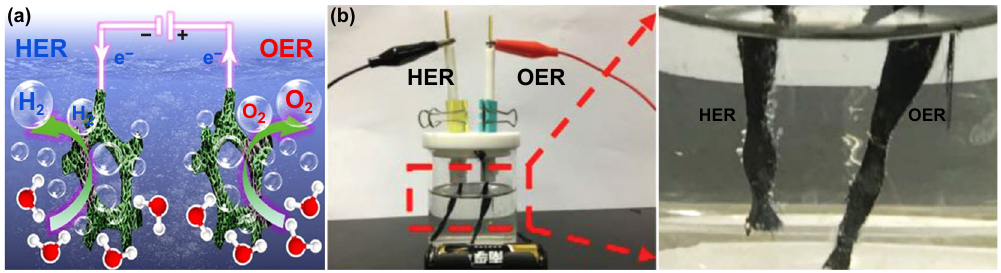
Fig. 2 a Schematic diagram of two-electrode configuration for overall water splitting with NF/T(Ni 3 S 2 /MnS–O) as anode and cathode. Repro- duced with permission from Ref. [33]. Copyright 2019 Elsevier Inc., b photographs showing the NiCo-nitrides/NiCo 2 O 4 /GF||NiCo-nitrides/ NiCo 2 O 4 /GF couple electrolyzer. Reproduced with permission from Ref. [53]. Copyright 2019 John Wiley and